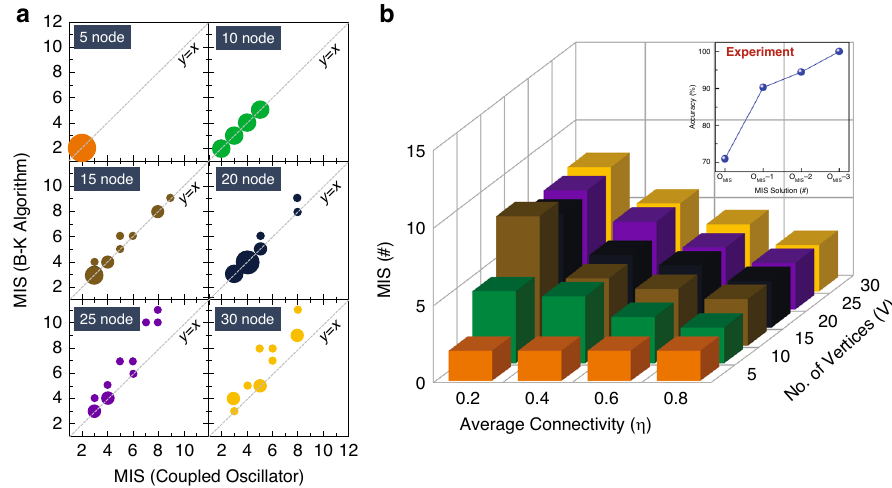
Fig. 2 MIS solution computed by the coupled oscillators. a MIS solution experimentally obtained from the coupled oscillators and its comparison with the optimal solution (computed using the B – K algorithm). b Evolution of size of the MIS (computed by the oscillators) as a function of graph size ( V ) and connectivity ( η ). The MIS solution increases with the size and the sparsity of the graph. The MIS for each ( V , η ) is averaged over the three measured random graph instances. Inset shows the overall accuracy as a function of the optimality of the MIS solution for the experimentally measured graph instances. O MIS represents optimal MIS solution, and O MIS - k is deviation from optimal MIS by k ( k = 1,2,3).